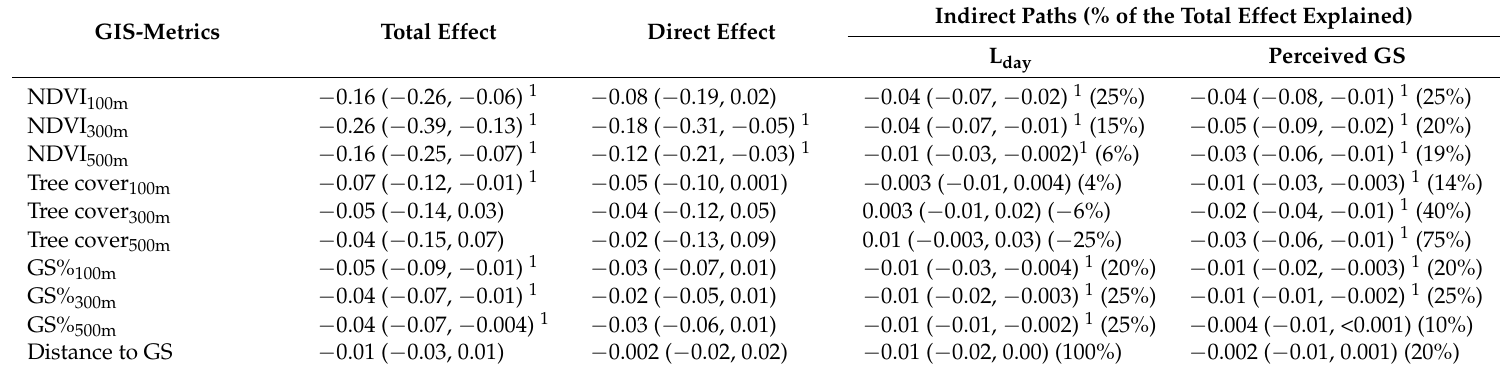
Table 2. Parallel mediation models linking Geographic Information System (GIS)-derived greenspace to noise annoyance ( N = 720).